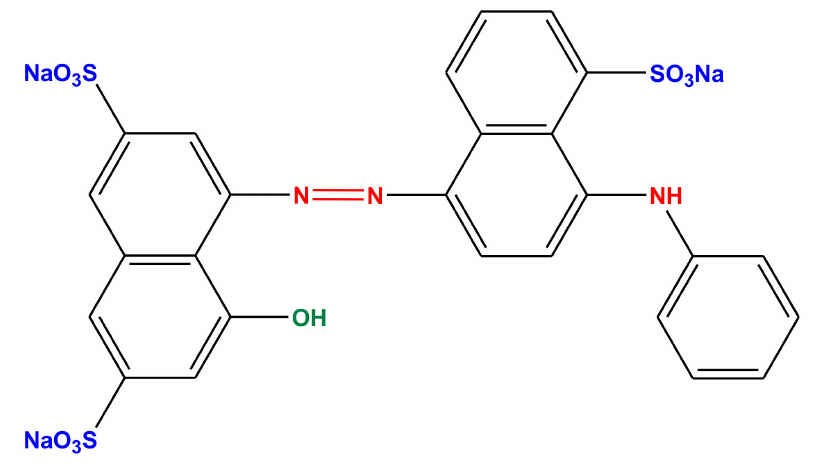
Figure 1. Structure of Acid Blue 92